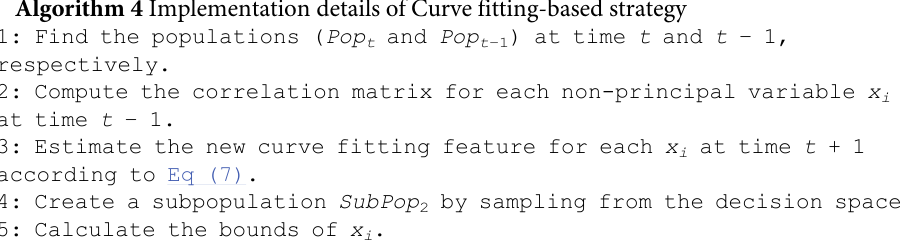
Algorithm 4 Implementation details of Curve fitting-based